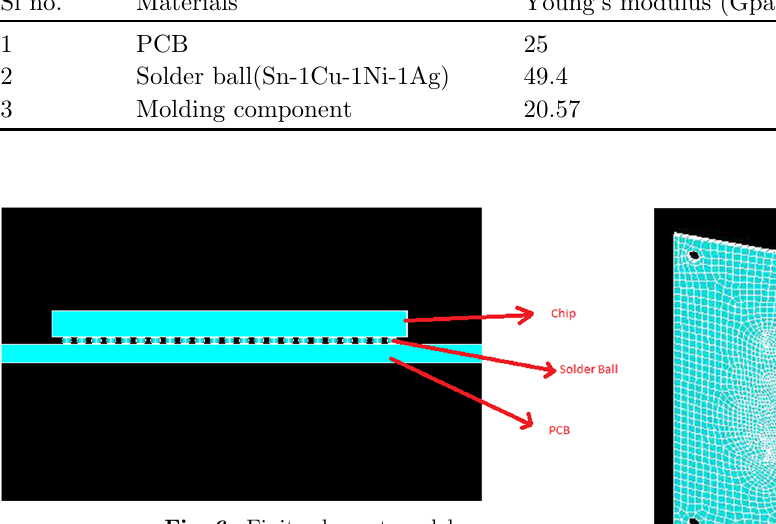
Table 2. Properties of the components. Sl no.